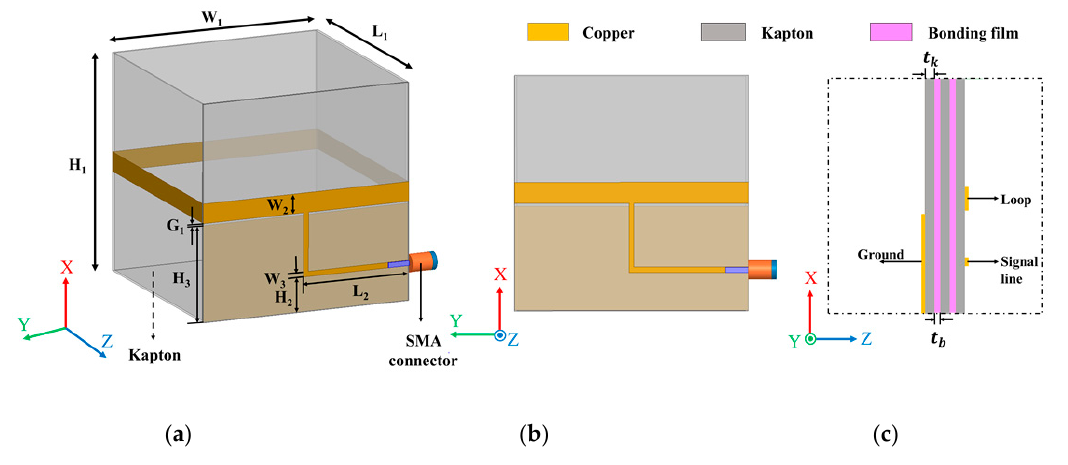
Figure 1. Illustration of the single magic cube antenna: ( a ) Angled view, ( b ) front view, and ( c ) overlapping layers at z = L 1 and y = W 1 .